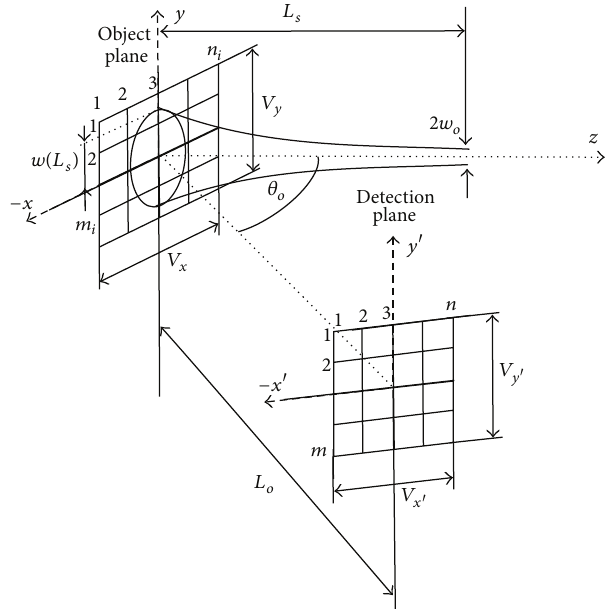
Figure 1: Geometrical arrangement for speckle pattern observation. Gaussian beam is incident on the object’s surface of size 𝑉 𝑥 × 𝑉 𝑦 sampled by 𝑚 𝑖 ×𝑛 𝑖 points. The radii of the Gaussian beam at its waist and at the distance 𝐿 𝑠 from the waist are 𝜔 𝑜 and 𝜔(𝐿 𝑠 ) , respectively. Reflected field is detected by the matrix detector of size 𝑉 𝑥 󸀠 × 𝑉 𝑦 󸀠 and a number of points 𝑚×𝑛 at the distance 𝐿 𝑜 and the observation angle 𝜃 𝑜 .